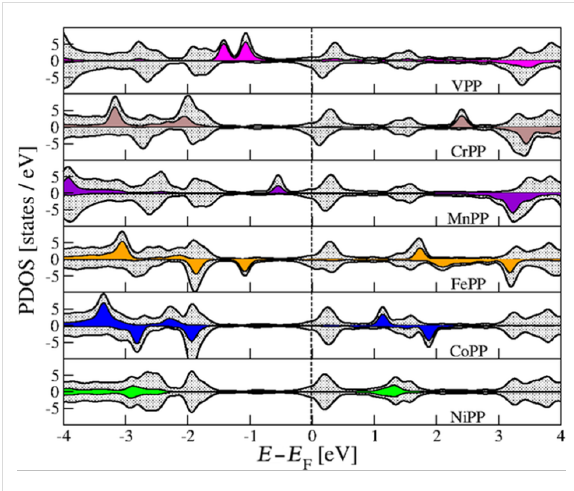
Figure 4: Density of states projected over the molecule (gray) and the central TM atom in the molecule. Spin-up and spin-down are repre- sented by their corresponding orientations. Fermi level of the metallic substrate was set to zero.